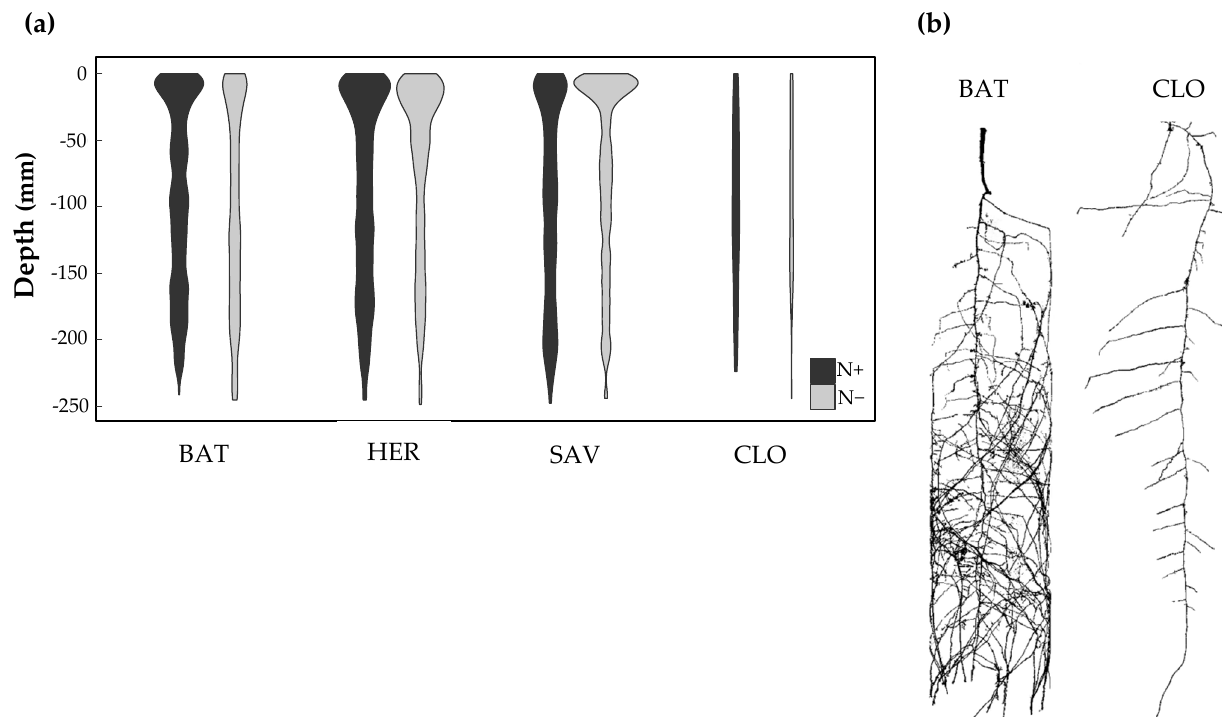
Figure 6. Characterization of the root system architecture in soil-filled column. ( a ) The violin plots show the distribution of lateral root density, as a function of the column depth. The estimates are based on five replicates of four oilseed rape cultivars cultivated with low (N − ) or high (N+) nitrate conditions; ( b ) Reconstructed images of two contrasting cultivars at N − . Scale bar = 5 cm.